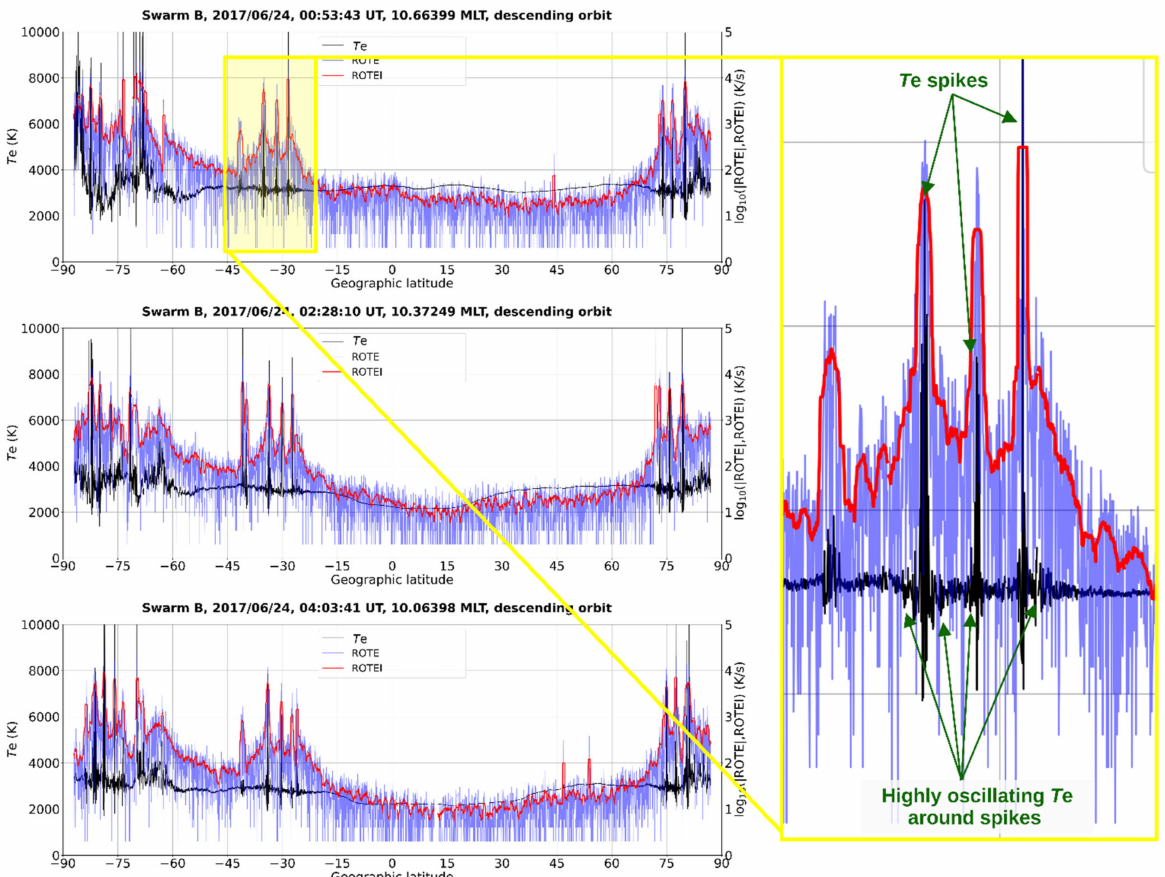
Figure 5. T e (in black), ROTE (in blue), and ROTEI (in red) time series for three consecutive descending semiorbits (from top to bottom panels), as recorded by Swarm B on 24 June 2017. The date, UT, and MLT of the equator crossing point are given on the top of each